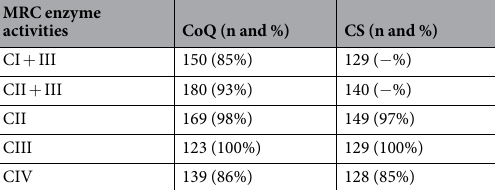
Table 4. Number of patients identified as having a correlation coefficient > 0.95 among the different MRC enzyme activities vs CoQ or CS, and the degree of agreement between the agglomerative and divisive methods in the number of calculated individuals, except for CS, Complexes I + III and II + III, in which the agglomerative algorithm did not provide any sensible results and only the divisive method was